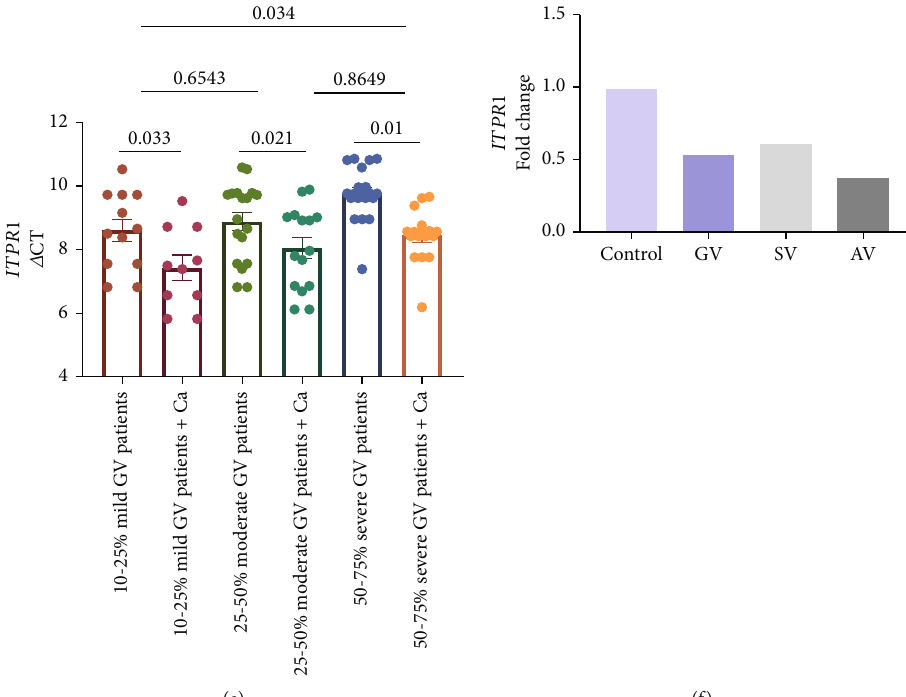
Figure 3: SERPINB9 and ITPR1 transcripts in Tregs of GV patients and controls. SERPINB9 and ITPR1 transcripts in Tregs of 52 GV patients and 48 controls were analyzed by nonparametric Mann – Whitney U test. (a) SERPINB9 transcripts in GV, SV, and AV vs controls ’ Tregs ( p = 0 : 0045 , p = 0 : 043 , and p < 0 : 0001 , respectively). SERPINB9 transcripts in AV vs SV Tregs ( p = 0 : 031 ). SERPINB9 transcripts in GV, SV, and AV Tregs before and after calcium treatment ( p = 0 : 0345 , p = 0 : 0432 , and p = 0 : 02 ). (b) SERPINB9 transcripts in severe GV (50-75% VASI) vs mild GV (10-25% VASI) Tregs ( p = 0 : 035 ). SERPINB9 transcripts in moderate GV (25-50% VASI) vs mild GV (10-25% VASI) and severe GV (50-75% VASI) Tregs ( p = 0 : 1162 and p = 0 : 1164 , respectively). SERPINB9 transcripts in mild GV, moderate GV, and severe GV Tregs before and after calcium treatment ( p = 0 : 034 , p = 0 : 02 , and p = 0 : 001 , respectively). (c) There was a 0.32-, 0.54-, and 0.25-fold changes in SERPINB9 transcripts for GV, SV, and AV Tregs when compared to controls. (d) ITPR1 transcripts in GV, SV, and AV vs controls ’ Tregs ( p < 0 : 0001 , p = 0 : 045 , and p < 0 : 0001 , respectively). ITPR1 transcripts in AV vs SV Tregs ( p = 0 : 0003 ). ITPR1 transcripts in GV, SV, and AV Tregs before and after calcium treatment ( p = 0 : 02 , p = 0 : 0327 , and p = 0 : 01 ). (e) ITPR1 transcripts in severe GV (50-75% VASI) vs mild GV (10-25% VASI) Tregs ( p = 0 : 034 ). ITPR1 transcripts in moderate GV (25- 50% VASI) vs mild GV (10-25% VASI) and severe GV (50-75% VASI) Tregs ( p = 0 : 6543 and p = 0 : 8649 , respectively). ITPR1 transcripts in mild GV, moderate GV, and severe GV Tregs before and after calcium treatment ( p = 0 : 033 , p = 0 : 021 , and p = 0 : 01 ). (f) There was a 0.54-, 0.62-, and 0.28-fold changes in ITPR1 transcripts for GV, SV, and AV Tregs when compared to